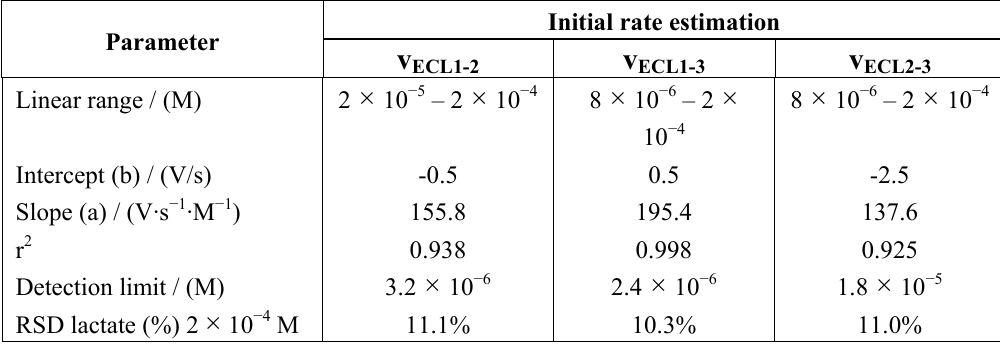
Table 1. Analytical parameters for different initial rate